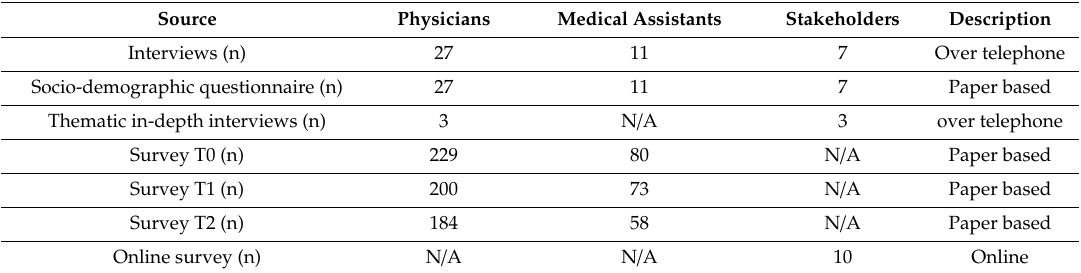
Table 6. Data collection sources and numbers of participants.